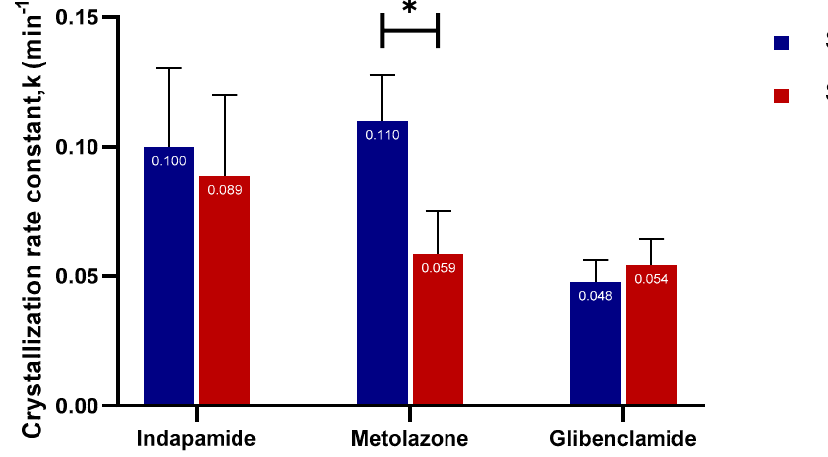
Figure 8. The crystallization rate constant, k (min − 1 ), of fresh and aged and / or crystallized spray-dried indapamide, metolazone, and glibenclamide. p < 0.05 is denoted *.